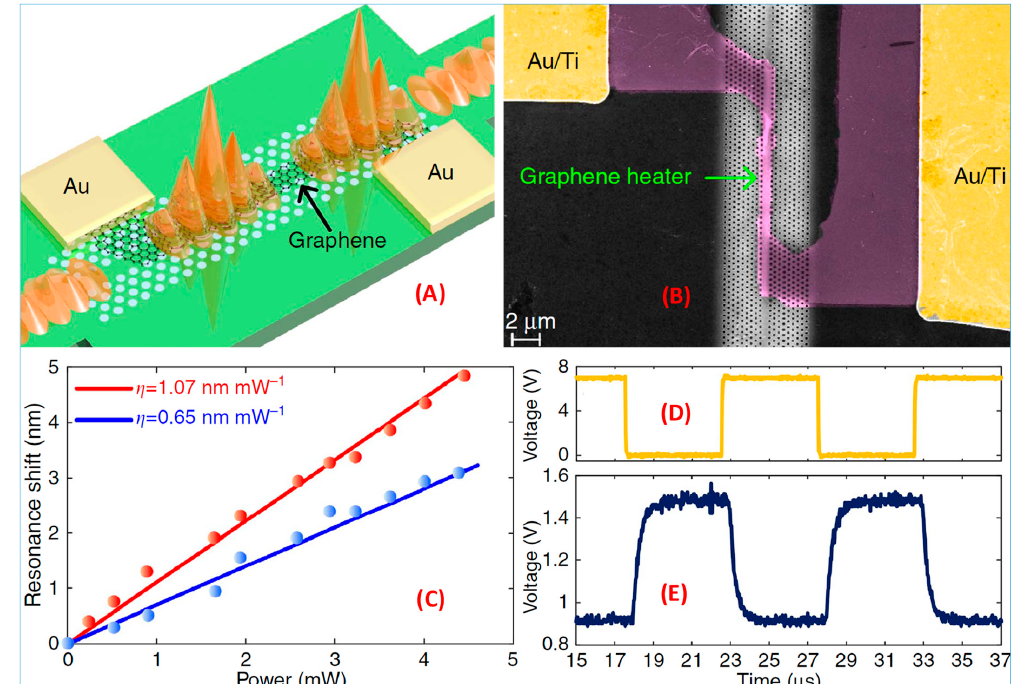
Figure 17. ( A ) Schematic of the slow-light-enhanced graphene heater. ( B ) False-color scanning electron microscope image of the slow-light-enhanced graphene heater. ( C ) Measured resonance shifts for the interference dips at 1525.12 nm (blue) and 1533.71 nm (red) as functions of the applied heating power. ( D ) Driving electrical signal and ( E ) corresponding temporal response signal [132]. Copyright 2017, Springer